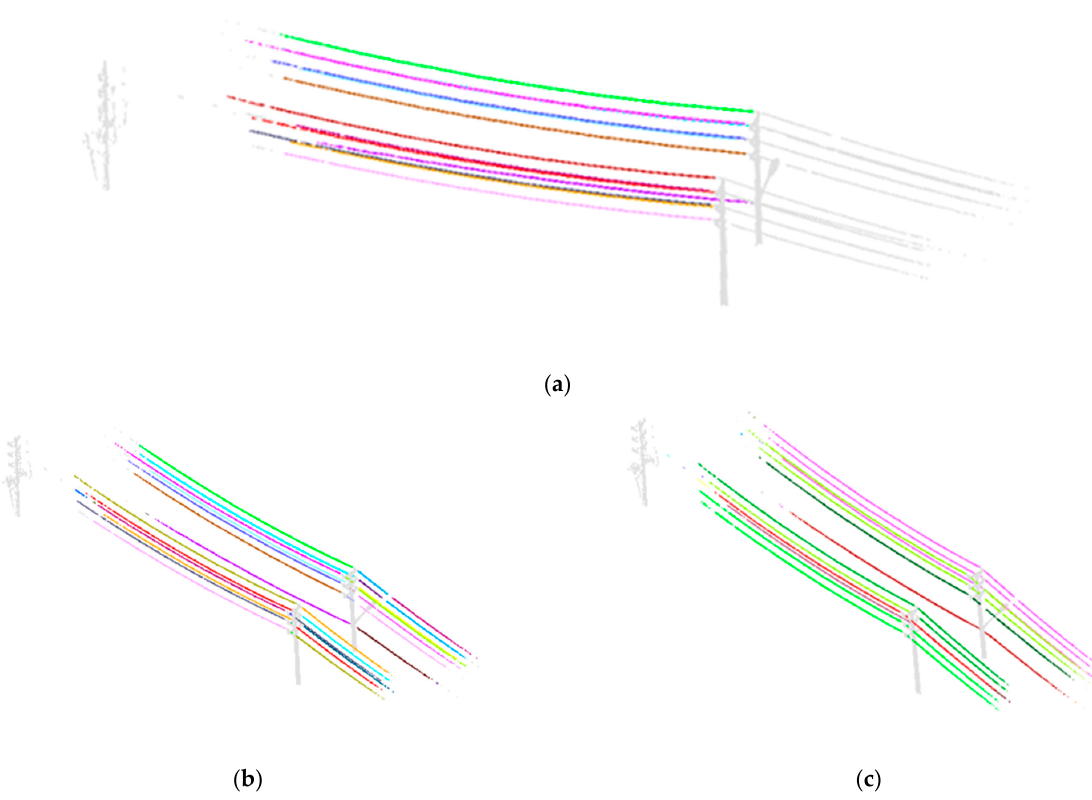
Figure 14. Using region growth and EC to extract powerlines from preprocessed data. Individual powerlines are distin- guished by different colors. ( a ) Insufficient extraction of the region growth method. ( b ) Over–clustering of EC due to the small constraint distance. ( c ) Misclassification of EC due to the large constraint distance.